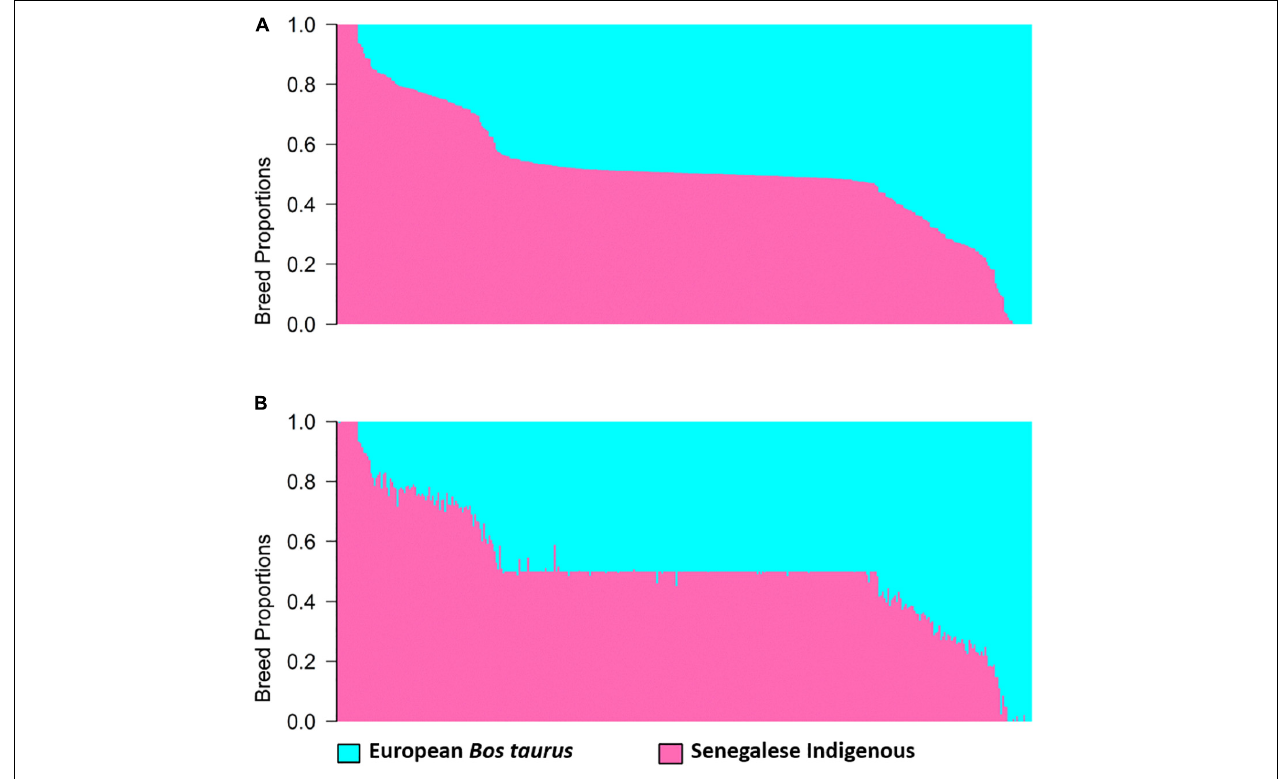
FIGURE 1 | Estimates of breed proportion of West African crossbreds using two-way admixture from (A) ADMIXTURE and (B) LAMP-LD.